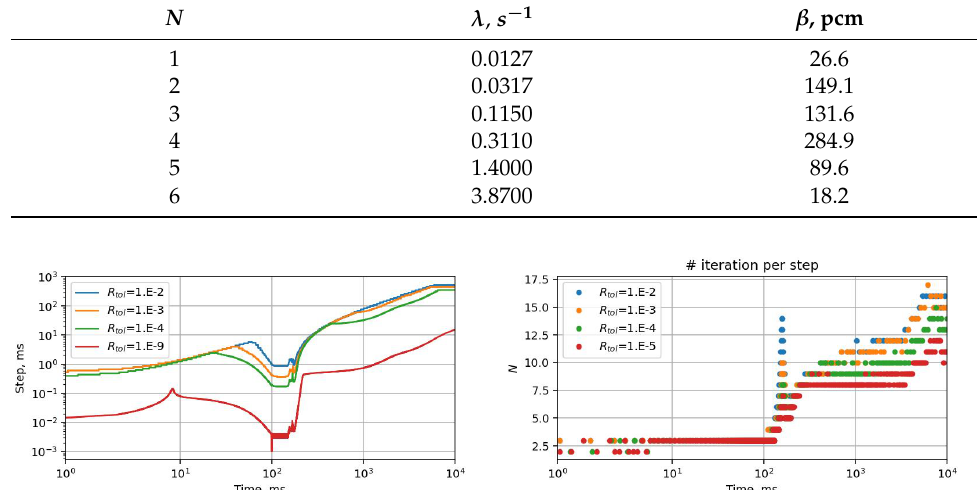
Figure A1. Time step size (on the left ) and number of fixed-point iterations (on the right